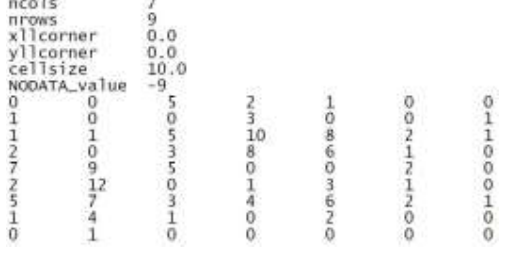
Figure 5. Simple test case – represented as raster input data